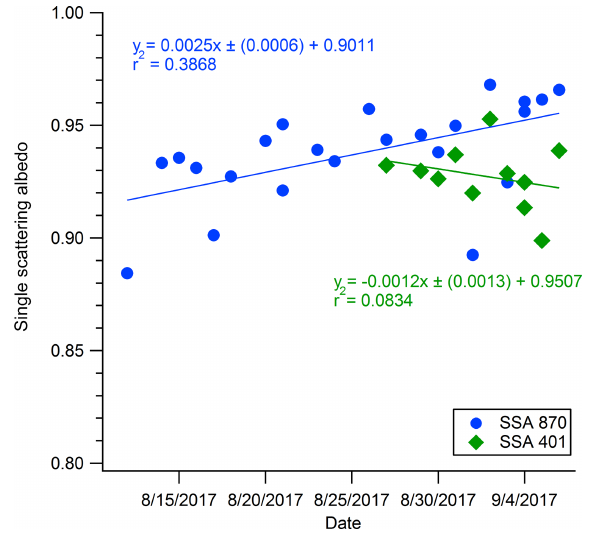
Figure 5. Plot of single scattering albedo over the course of the ambient smoke-monitoring period. Points represent SSA from ab- sorption and scattering integrated over smoke-impacted